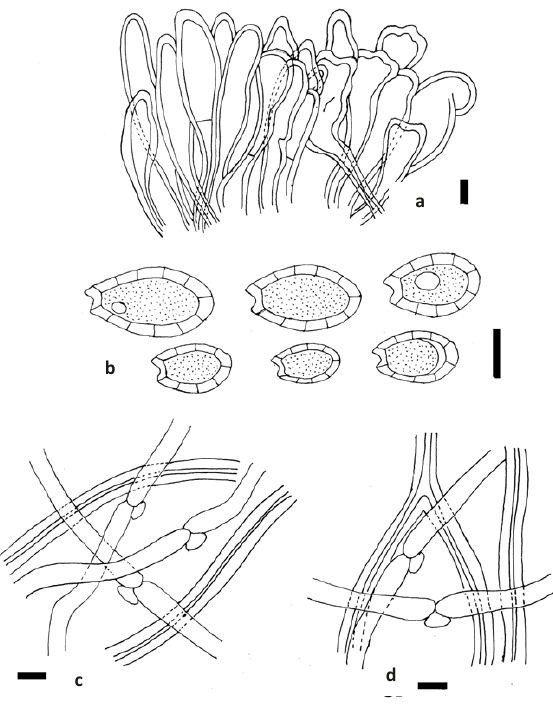
Figure 6. Ganoderma resinaceum . a - hyphae of the cutis, b - basidiospores, c - context hyphae, d - tube layer hyphae. Bars = 5µm. Drawing by R.